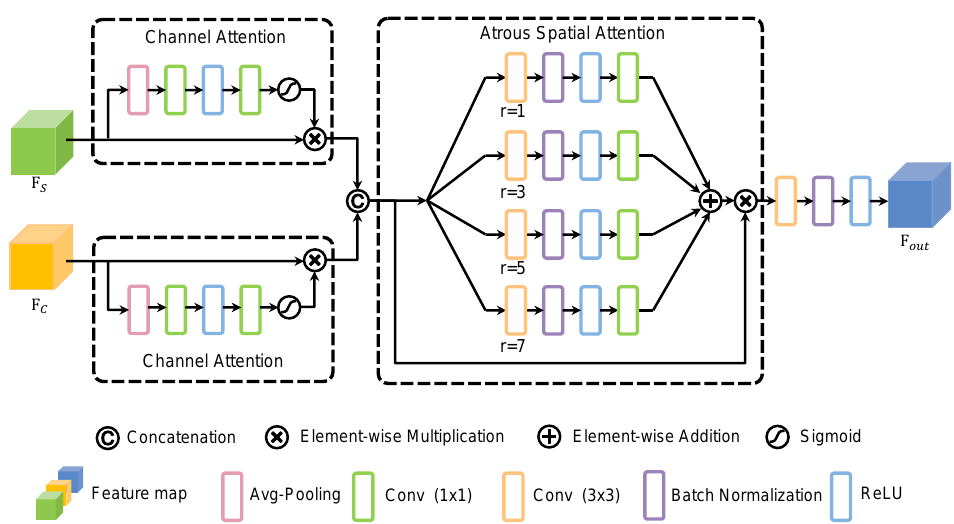
Figure 3. The design of the channel and atrous spatial fusion block (CAS-FB). The dual-channel attention modules correct the features of different tasks, and the atrous spatial attention module can aggregate the blood vessel features of different